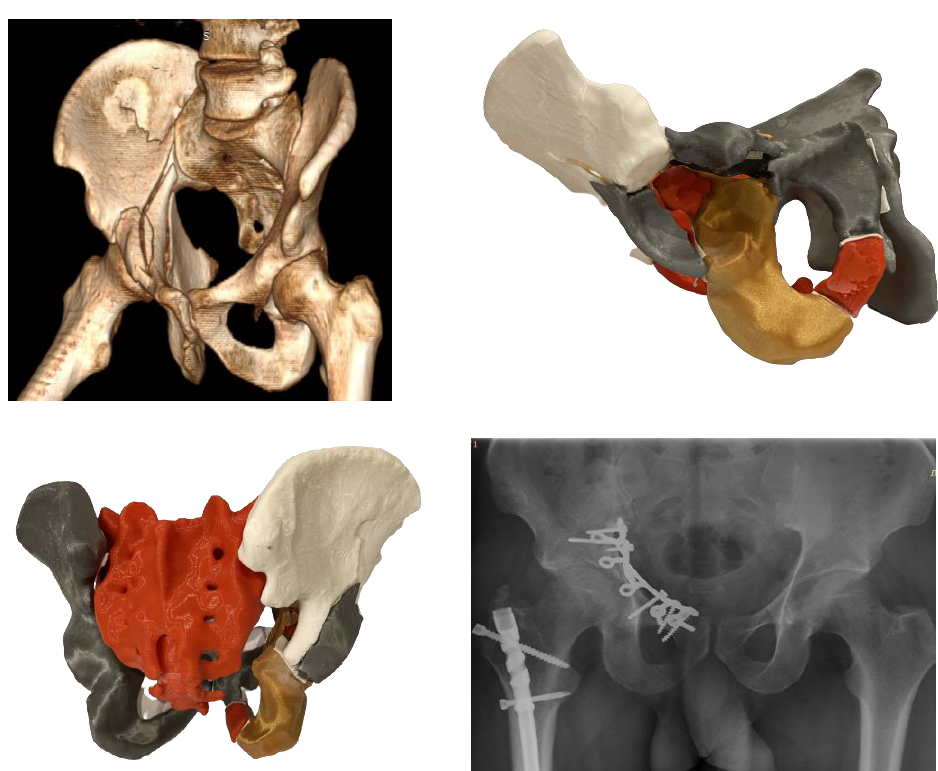
Figure 5. A reconstructed CT scan from a clinical case with substantial comminution of the quadrilateral surface ( top left ). A corresponding 3D printed pelvis model in (1) inside view, with extracted femoral head for better visualization of the intra-articular acetabular surface ( top right ), and (2) posterior view ( bottom left ), demonstrating comminution of both the posterior column and posterior wall. A postoperative radiographic image of the fixation with an omega plate ( bottom right ).